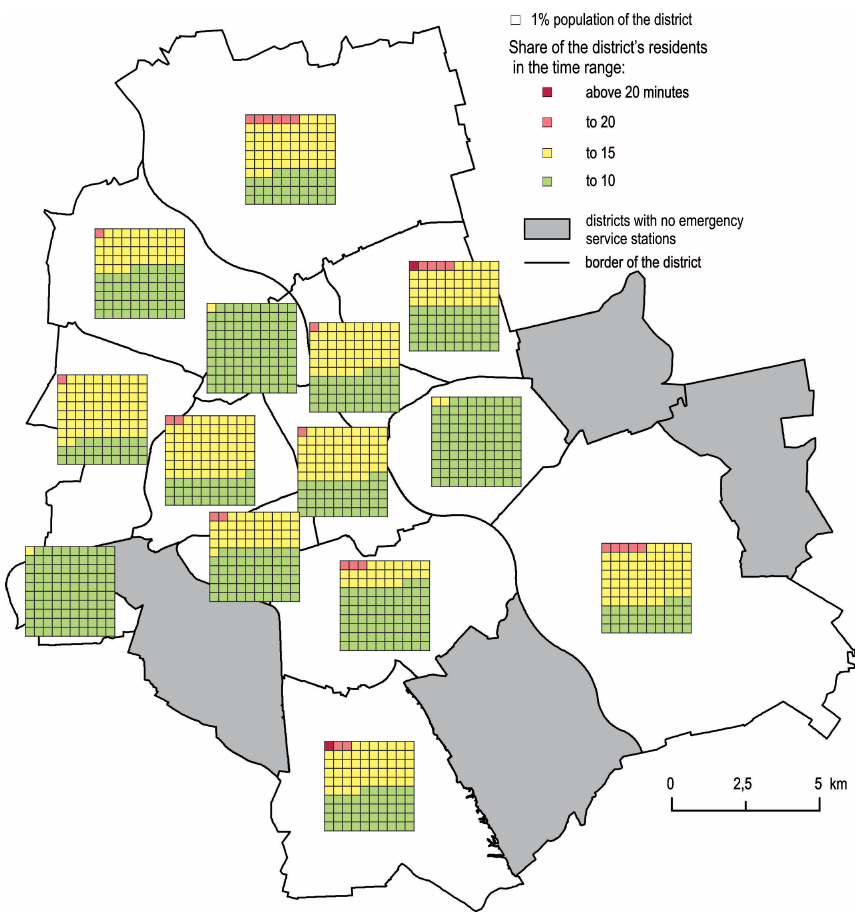
Fig. 4. Share of inhabitants in a given district’s time range (own